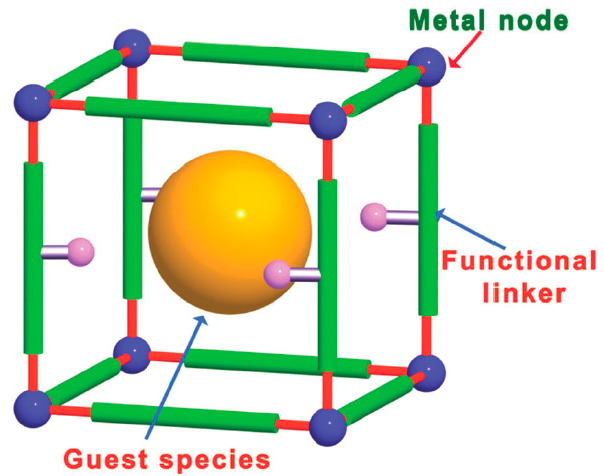
Figure 1. Possible location of active sites in MOFs, including metal nodes, functionalized organic linkers, and guest species such as MNPs in the pores. Reproduced with permission from [24].